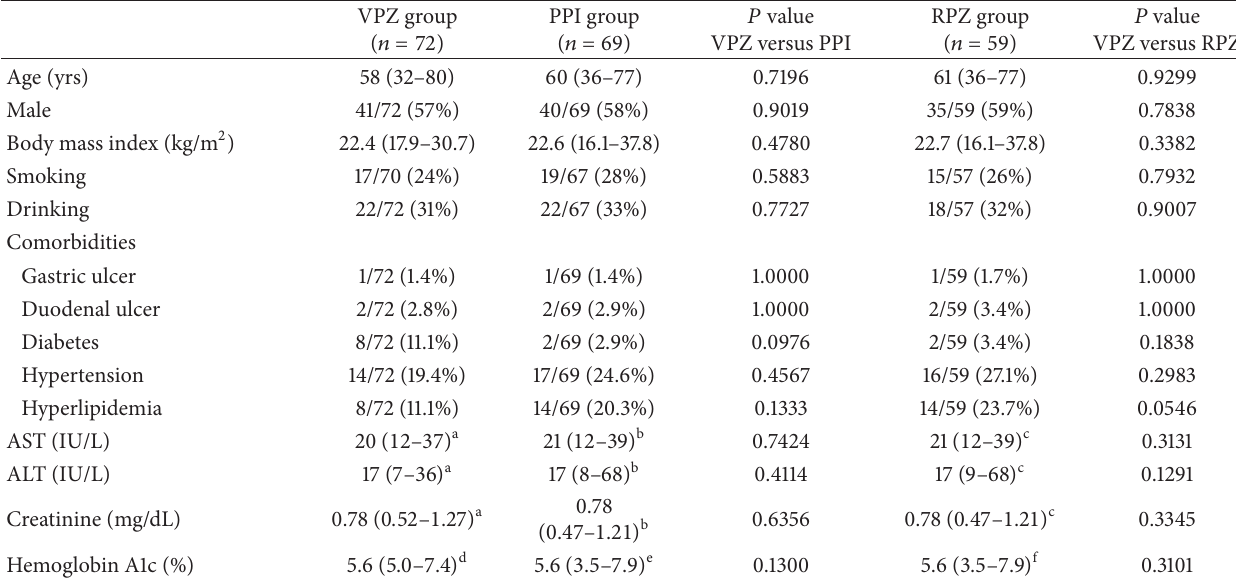
Table 1: Baseline characteristics of the participants.